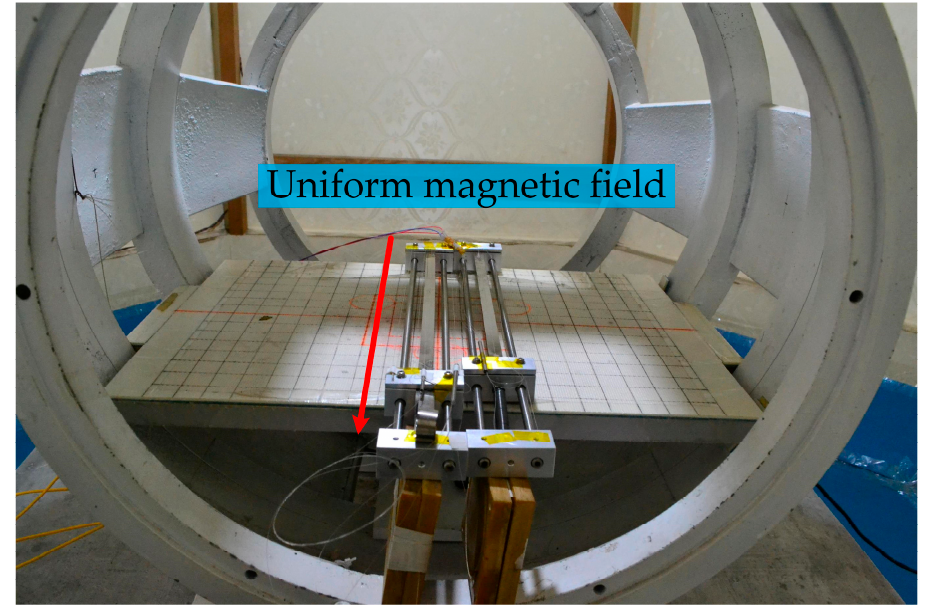
Figure 6. Simultaneous measurement of two optical fiber magnetic field sensors.